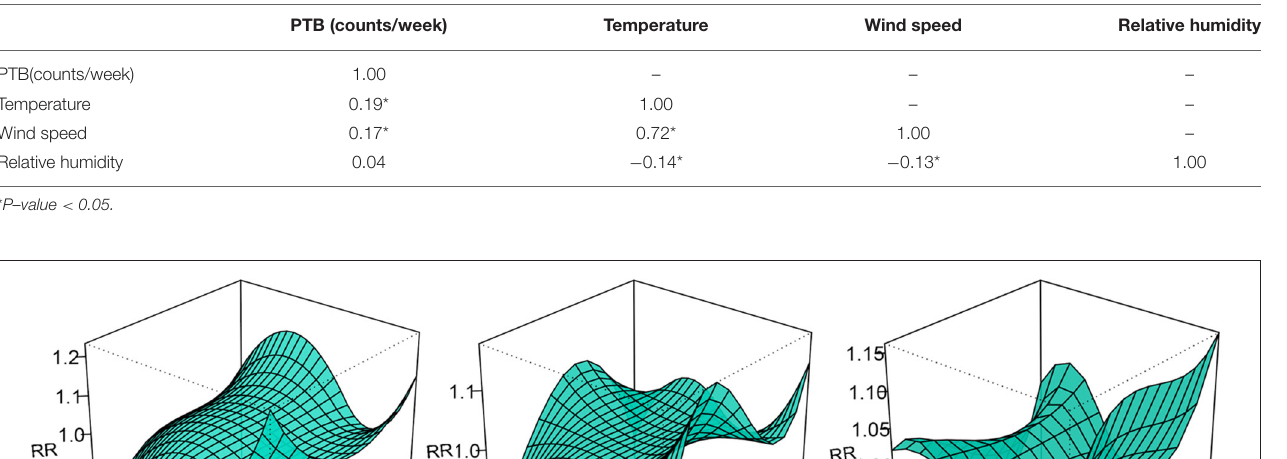
TABLE 2 | Spearman’s correlation between temperature, relative humidity, wind speed, and PTB.